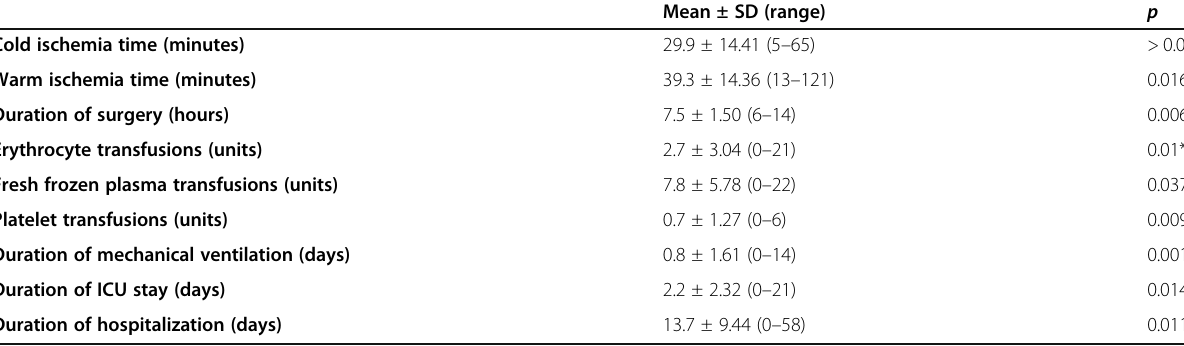
Table 2 Clinical data during the intra and early postoperative phases